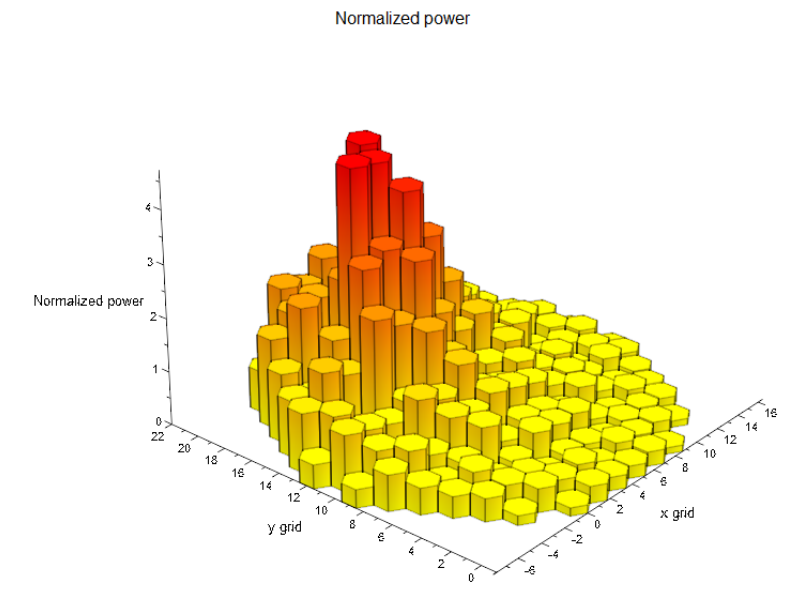
Figure 9. Averaged radial normalized power profile.